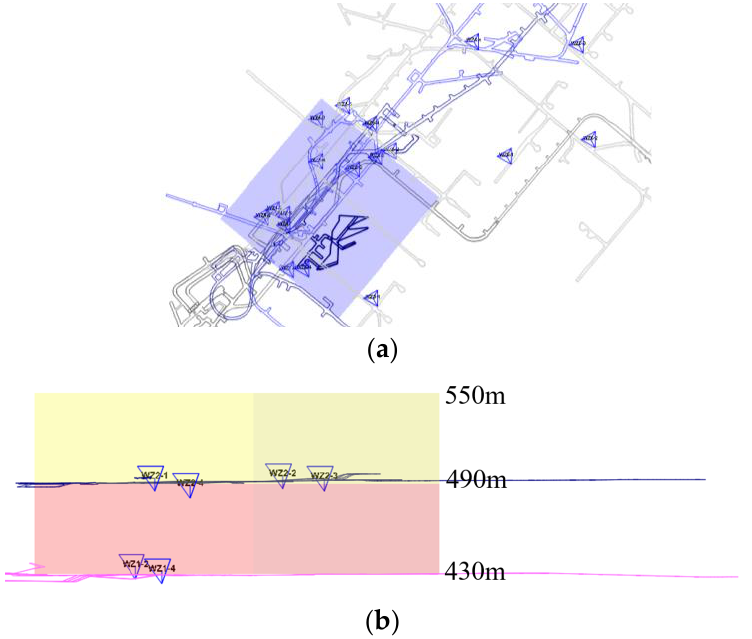
Figure 8. Focused analysis area model diagram: ( a ) top view; ( b ) north view. The shading in ( a ) indicates the analysis area, the different colors in ( b ) indicate different analysis areas.